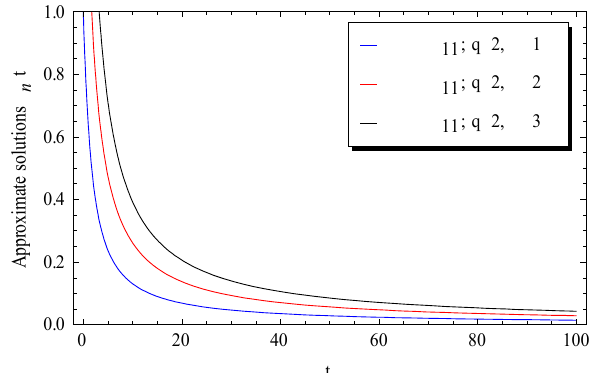
Figure 7. Effect of initial condition λ on the Adomian approximate solutions at q = 2.